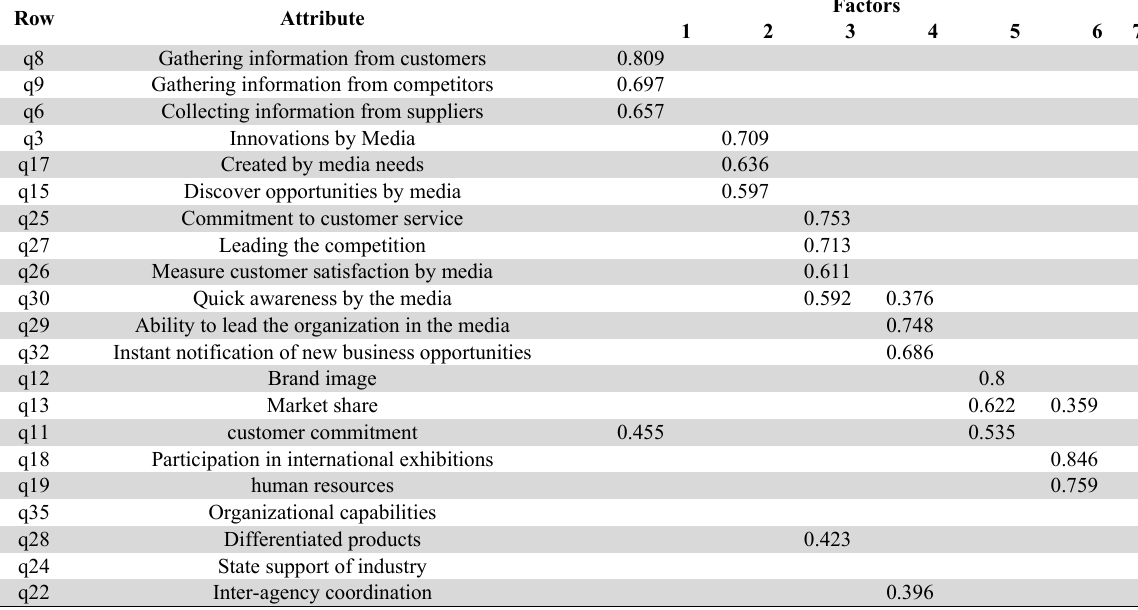
The results of factor loading after the rotation happens